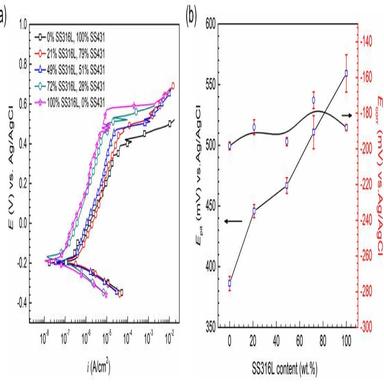
(a) Potentiodynamic polarization curves at different SS316L content zones in 3.5 wt.% NaCl solution after 0.5 h of immersion using the proposed test system; (b) variation of Epit and Ecorr values with different SS316L content zones.